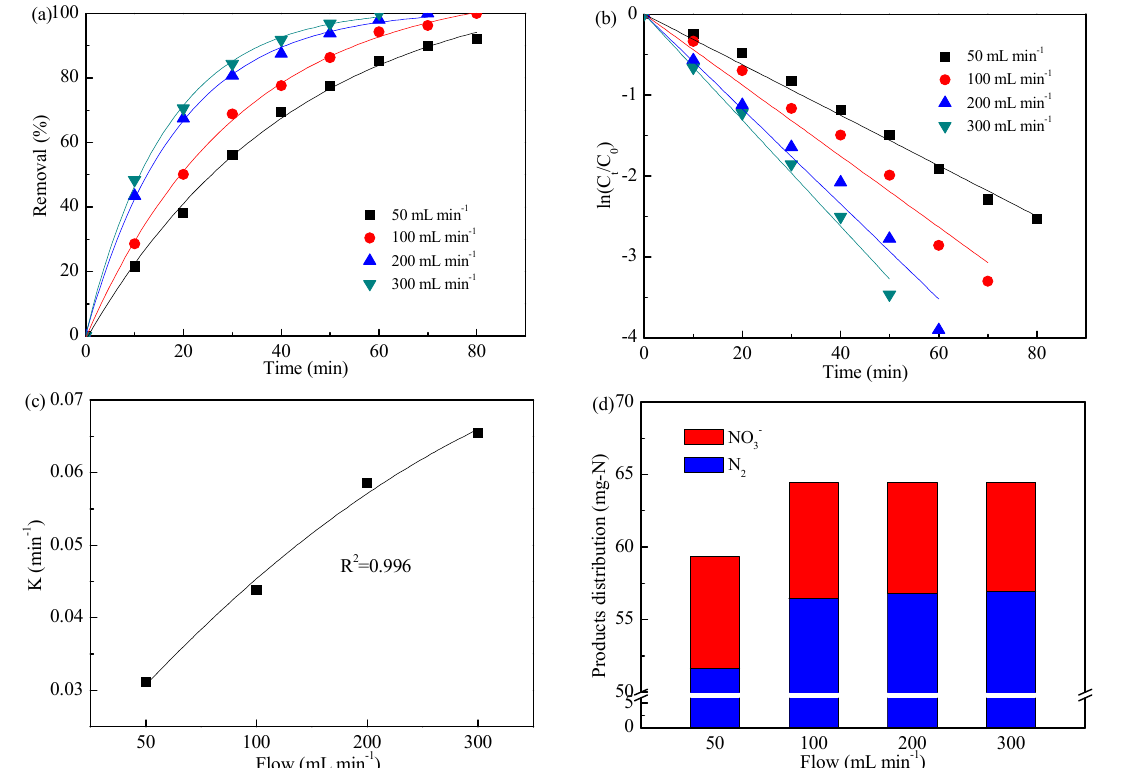
Figure 4. Impact of flow on ammonia removal ( a ), kinetics analysis ( b ), kinetics relationship ( c ), and products distribution ( d ). Initial pH value of 8.3, applied current density of 20 mA cm − 2 , and NaCl concentration of 1.0 g L − 1 .